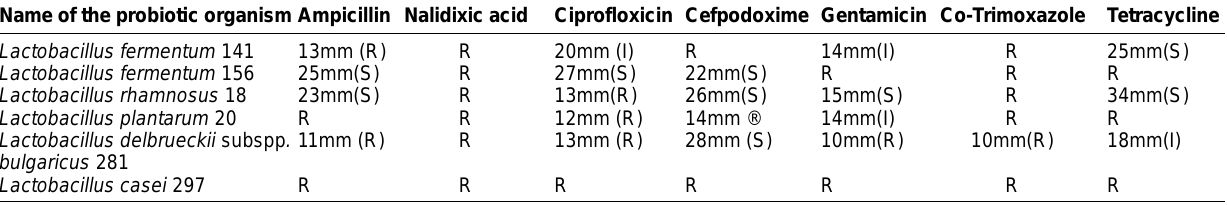
In brackets R=Resistant S=Sensitive, I=Intermediatory according to the performance standards for antimicrobial disc suspension tests [24]. Table-4. Antibacterial activity of Lactobacillus spp. against various pathogenic bacteria Name of the probiotic